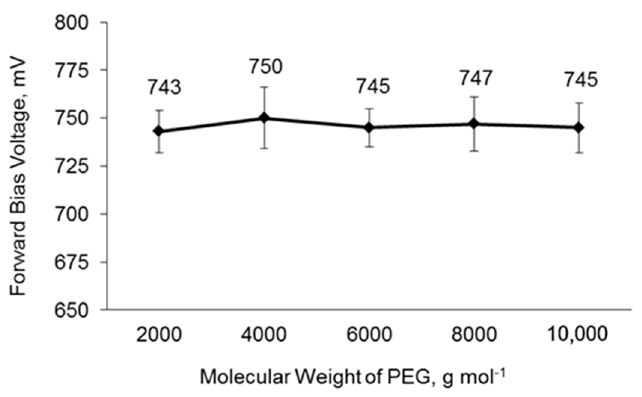
Figure 8. Forward bias voltage of DSSCs based on PU matrices with different PEG molecular weights.